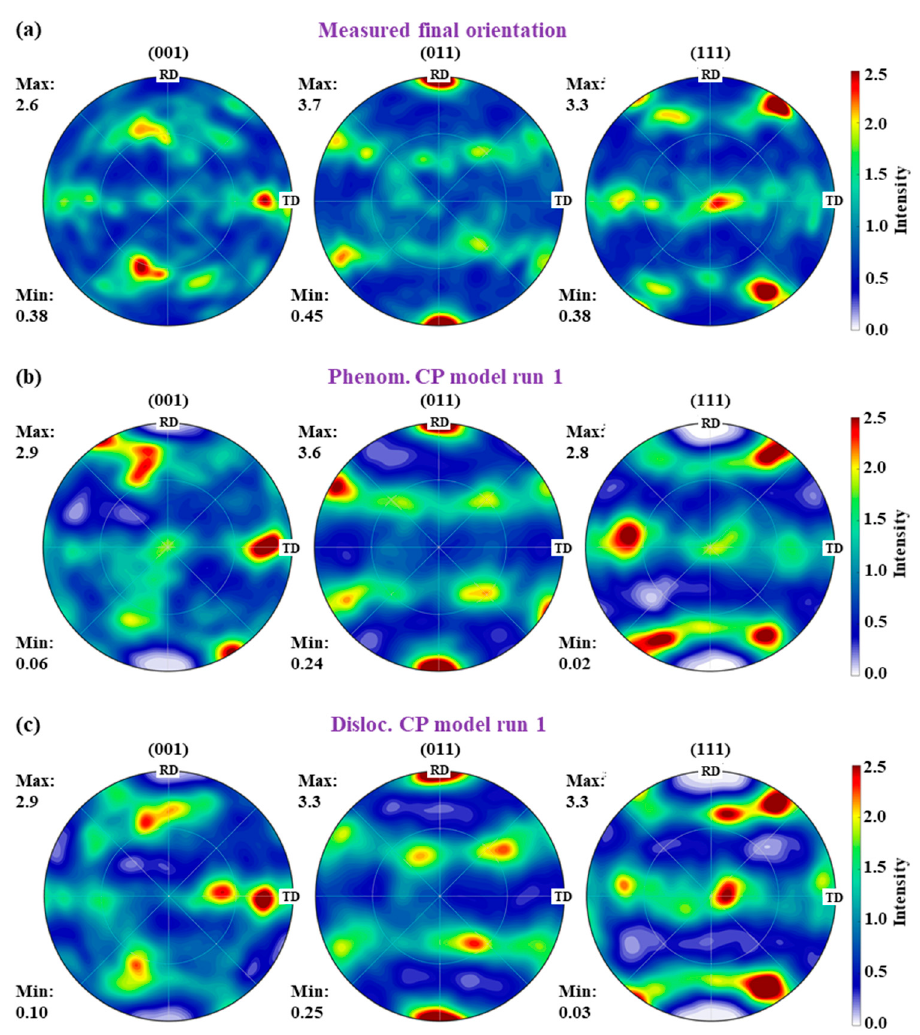
Figure 12. Pole figure of ( a ) measured final orientation, ( b ) phenomenological CP model run 1, and ( c ) dislocation-density-based CP model run 1. ( c ) dislocation-density-based CP model run